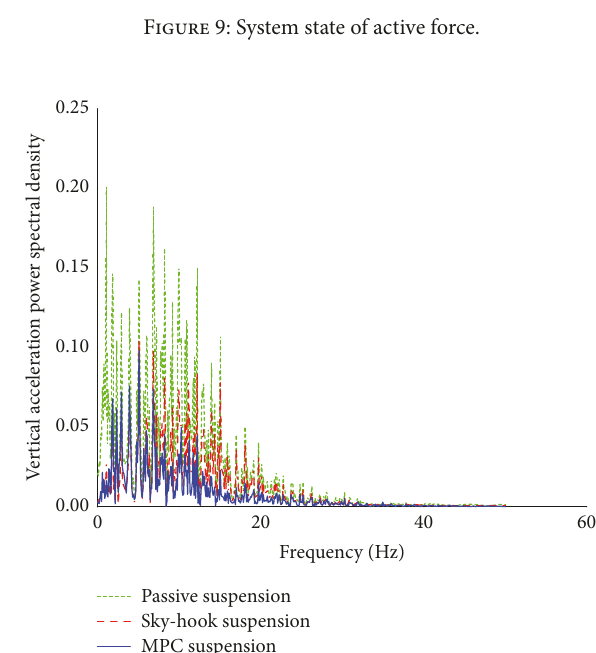
Figure 9: System state of active force.